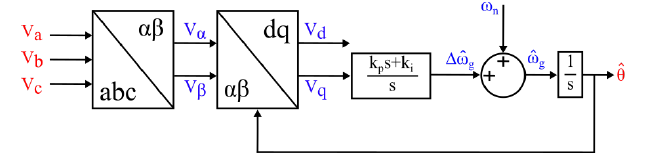
Figure 24. Schematic diagram of basic PLL.